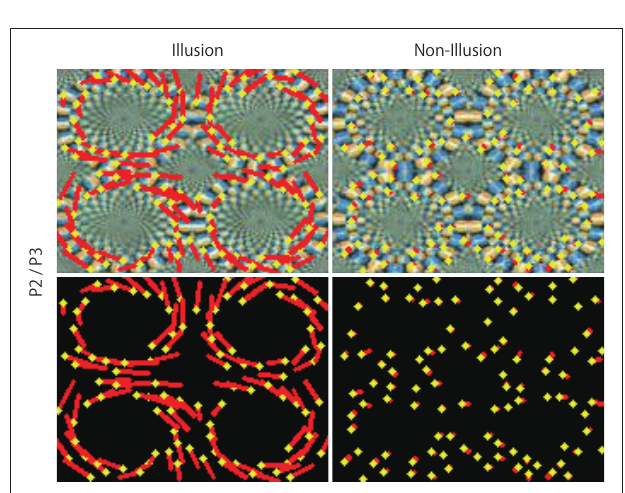
the time series change of the characteristics of the hidden units.